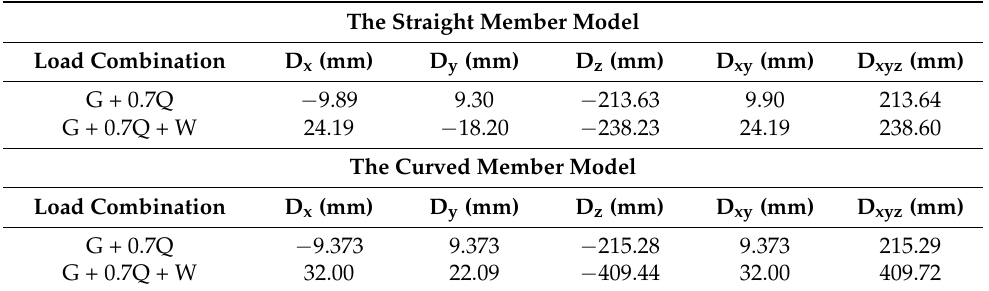
Table 10. Maximum structural displacement under serviceability limit state (linear static analysis). The Straight Member